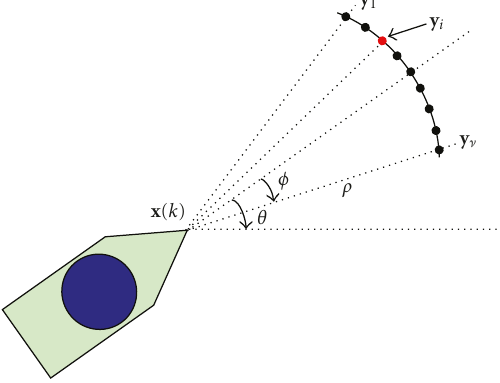
Figure 2: Evaluation of the mobile node’s next